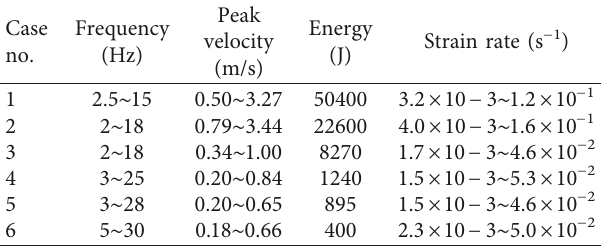
Figure 10: Vertical stress of 21304 gob after simulation step no. 4. (a) Variation trend of vertical stress in 21304 gob. (b) Simulated vertical stress distribution in 21304 gob. Table 6: Statistics of the dynamic loading induced by mine seismicity.